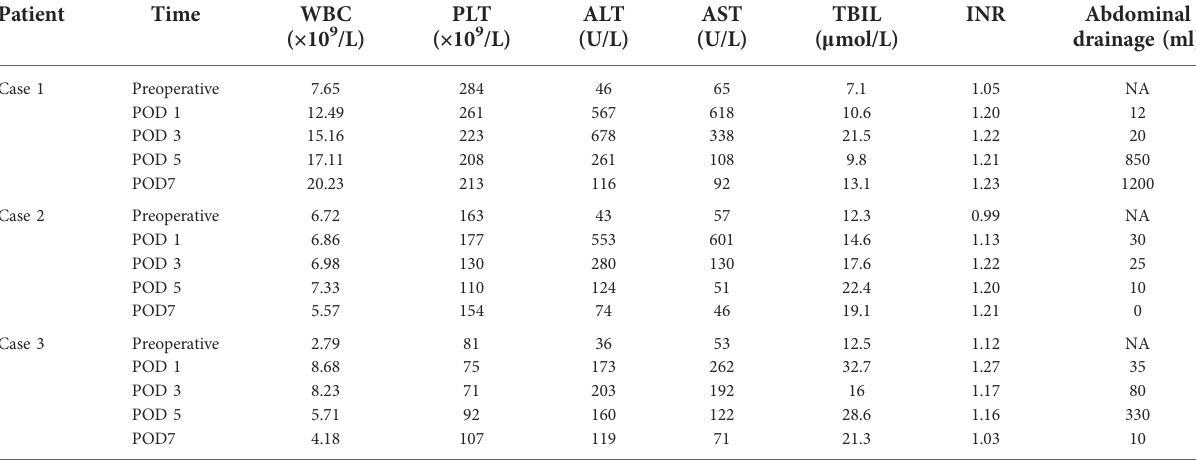
TABLE 3 Clinical characteristics of the three cases about preoperative and postoperative.